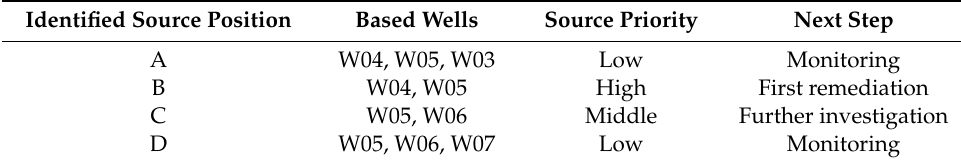
Table 2. Ranked list of potential source